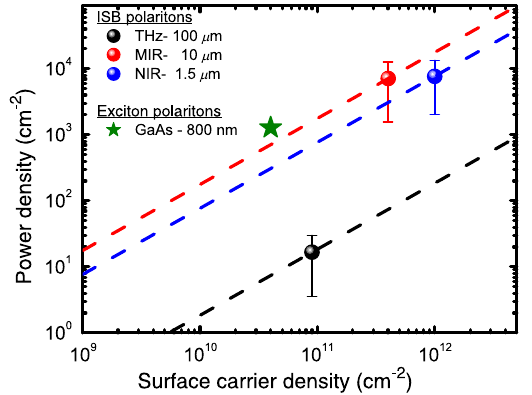
FIG. 4. Power density as a function of the surface carrier density of polaritons for the studied spectral regions. The green star marks the maximum power density for excitonic polaritons at 800 nm in the GaAs = AlGaAs inherently fixed by the Mott